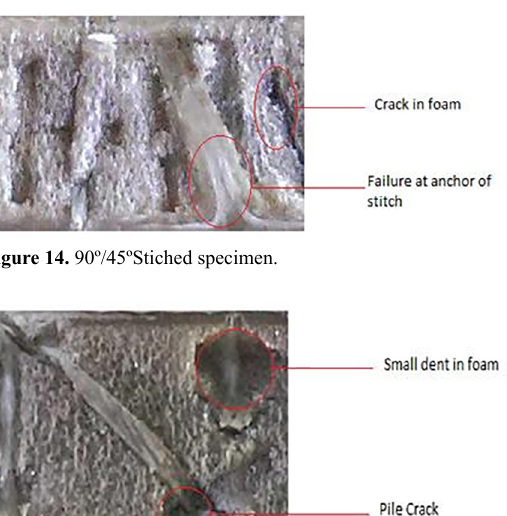
Figure 13. 45º Stitched specimen.